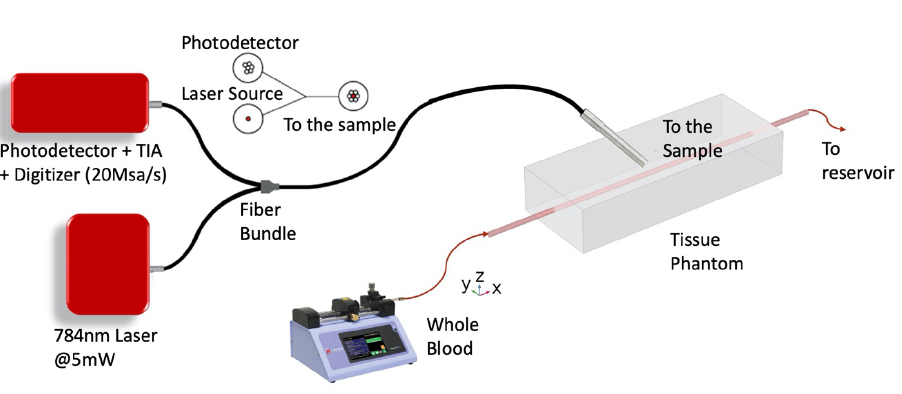
Figure 1. Experimental Setup. The laser light illuminates the tissue phantom surface at a 45-degree angle and the scattered diffused light is collected through the reflection probe fiber bundle which is coupled to a photoreceiver. The glass tube that emulates a blood vessel is embedded in the tissue phantom 5 mm below the